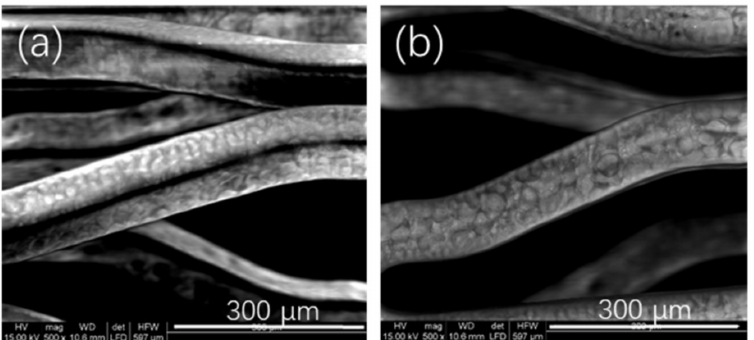
Figure 1. Morphologies of coating surfaces made by different concentrations of P34HB. ( a ) 28 mg/mL; ( b ) 30